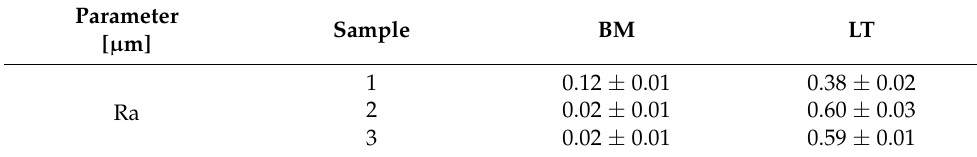
Table 7. Results for properties of roughness.